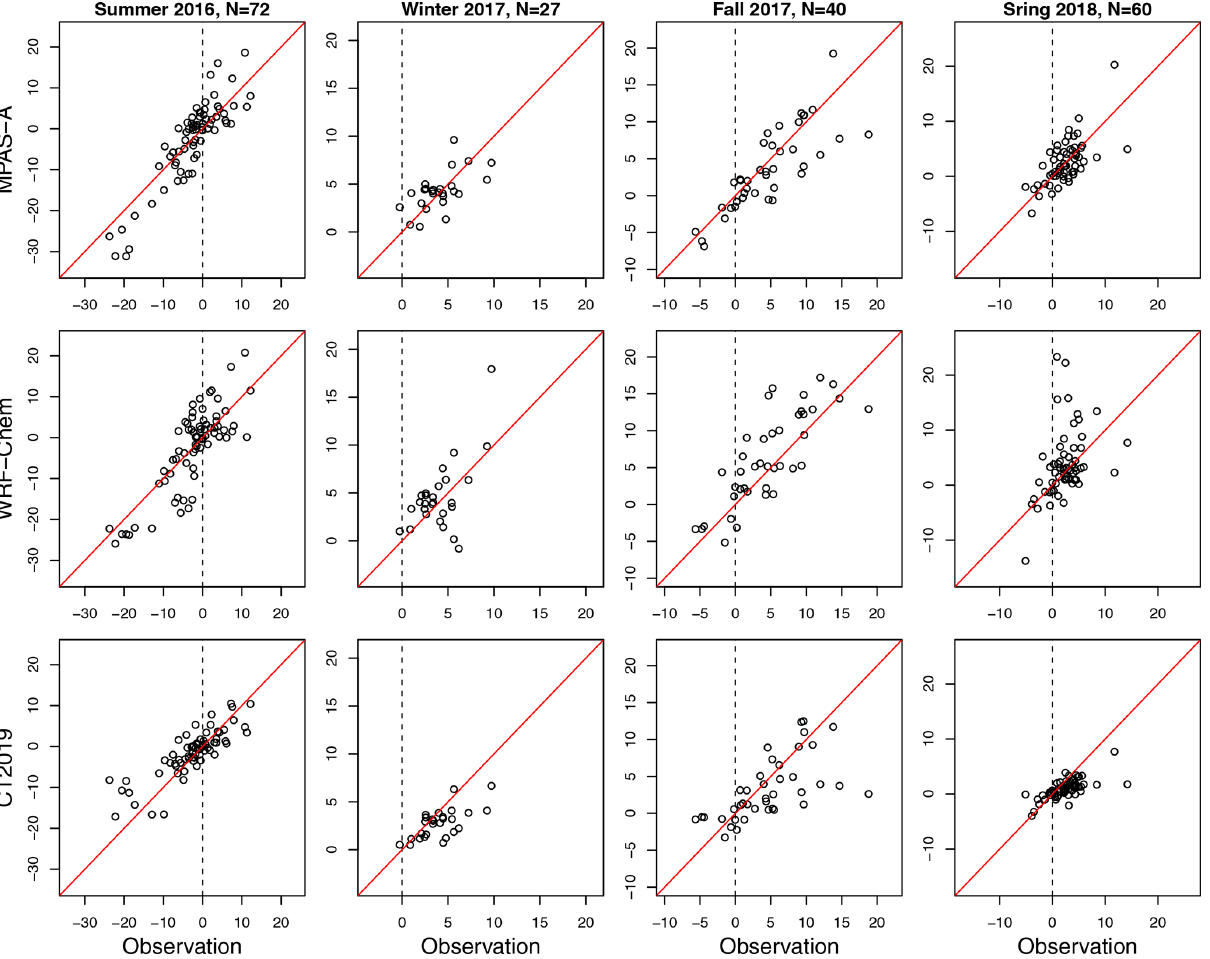
Figure 11. The difference of mean CO 2 mole fraction between boundary layer (BL) and free troposphere (FT) ( (cid:49) [ CO 2 ] = [ CO 2 ] BL − [ CO ] FT ) at vertical profiling flight legs. In each subplot, each open circle represents an individual vertical profiling flight leg, and its values 2 on the x axis and y axis represent its (cid:49) [ CO 2 ] value from the aircraft observations and the model simulation, respectively. (cid:49) [ CO 2 ] values from MPAS-A simulations are in the first row, WRF-Chem the second row, and CT2019 the third. The four columns in the figure are for the four ACT campaign seasons. The number of vertical profiles in each season is labeled in the column title. The vertical dashed line marks where (cid:49) [ CO 2 ] = 0 based on the aircraft measurements.